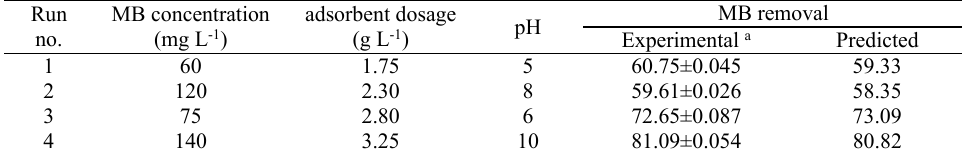
Table 6. Comparing the experimental and predicted values. Table 6: Comparing the experimental and predicted values.